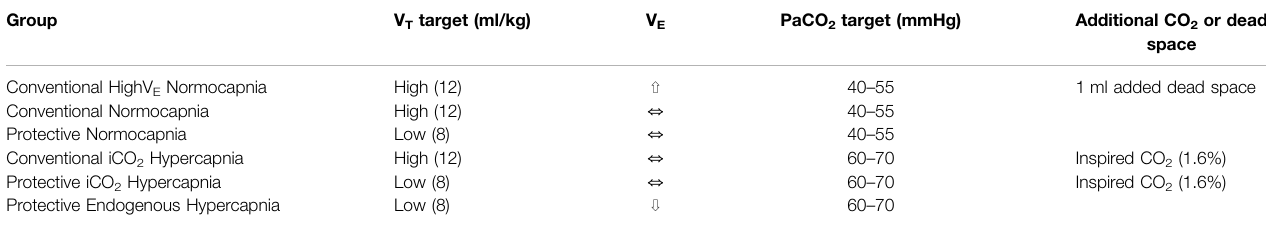
TABLE1| Summaryoftargetventilationsettings,includingtidalvolume(V T ,ml/kg),minuteventilation(V E ),partialarterialpressureofcarbondioxide(PaCO 2 ,mmHg),andthe addition of inspired CO 2 gas or dead space.